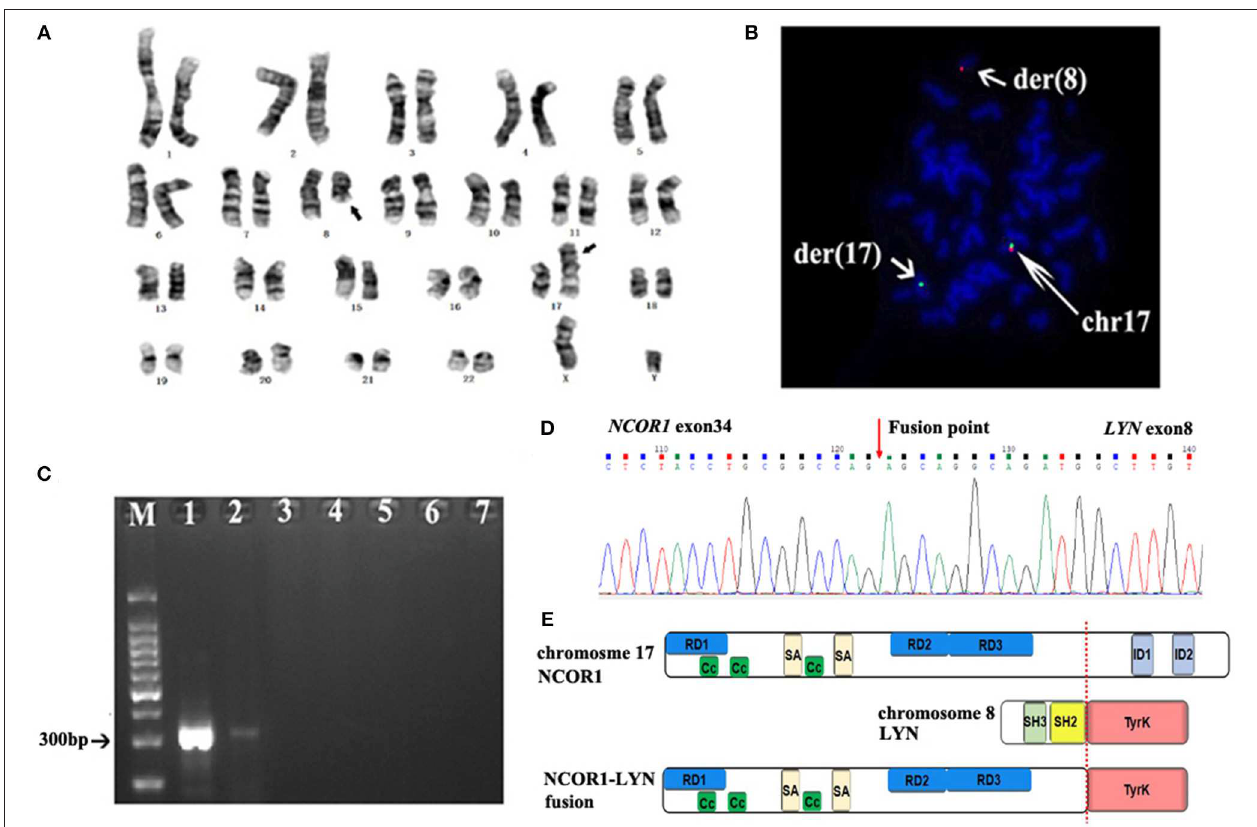
FIGURE 1 | G-banding analysis of the BM sample at relapse, which showed the balanced translocation t(8;17)(q12;p11.2). (B) FISH with a chromosome 17 centromere probe (green) and a TP53 probe (red) showed one of the TP53 signals on the der ( 8) chromosome, suggesting that the chromosome 17p breakpoint is centromeric to TP53 on 17p13. (C) RT-PCR showed various levels of NCOR1-LYN fusion transcript in bone marrow specimens. Lane 1: relapse sample; lane 2: 2 weeks after dasatinib; lane 3: 1 month post allo-HSCT; lane 4: 2 months post allo-HSCT; lane 5: 3 months post allo-HSCT; lane 6: 10 months post allo-HSCT; lane 7: negative control. (D) Sanger sequencing result of the NCOR1-LYN fusion gene, confirming a fusion between exon 34 of NCOR1 and exon 8 of LYN . (E) Schematic representation of the predicted domain structure of the NCOR1-LYN fusion.